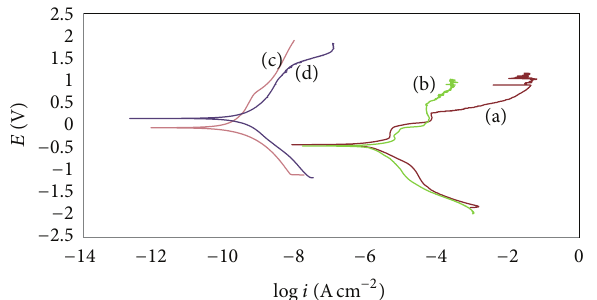
Figure 4: Polarization plots for (a) bare substrate, (b) 200 ∘ C, (c) 400 ∘ C, and (d) 700 ∘